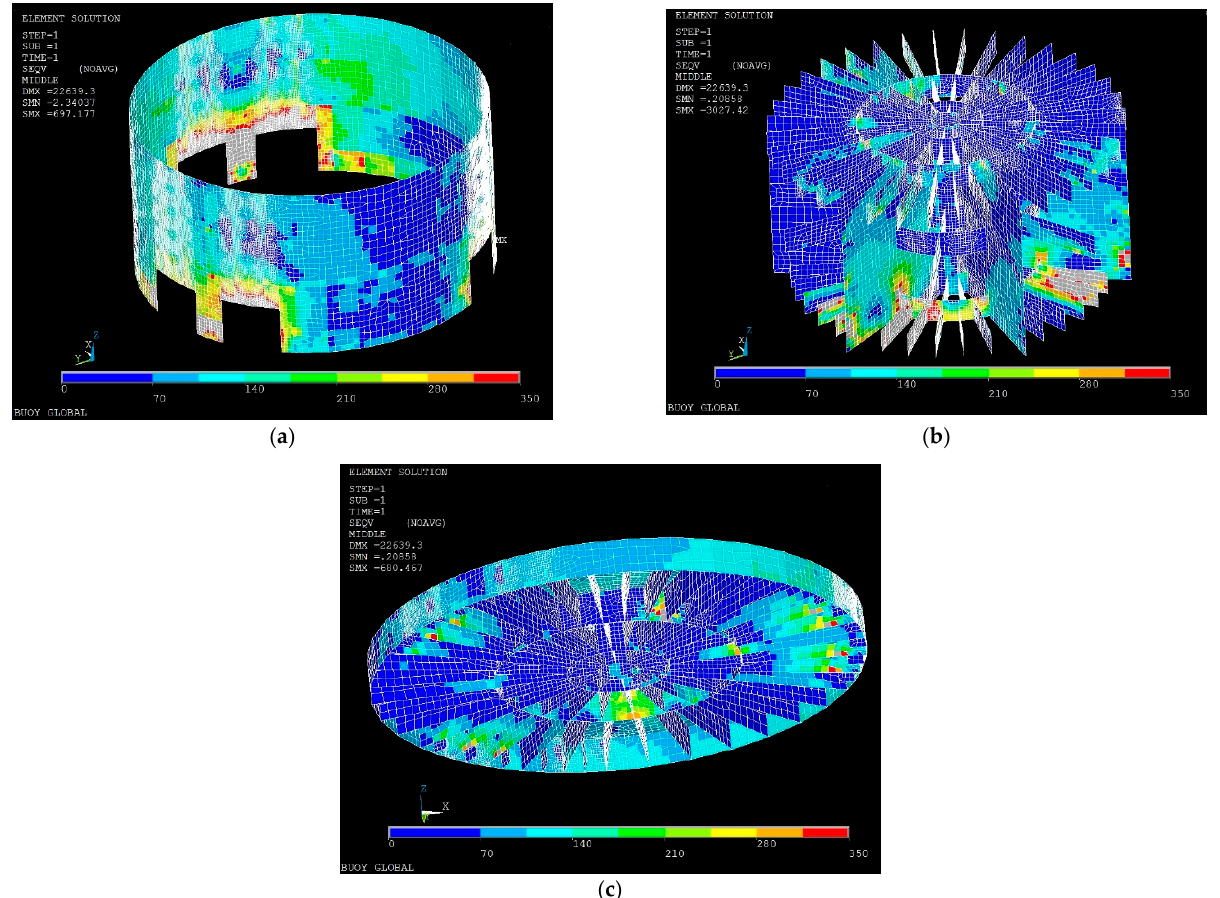
Figure 20. Mooring buoy structure global FEA results: ( a ) shell plating; ( b ) internal structure; ( c ) deck and underdeck structure near turntable bearing.